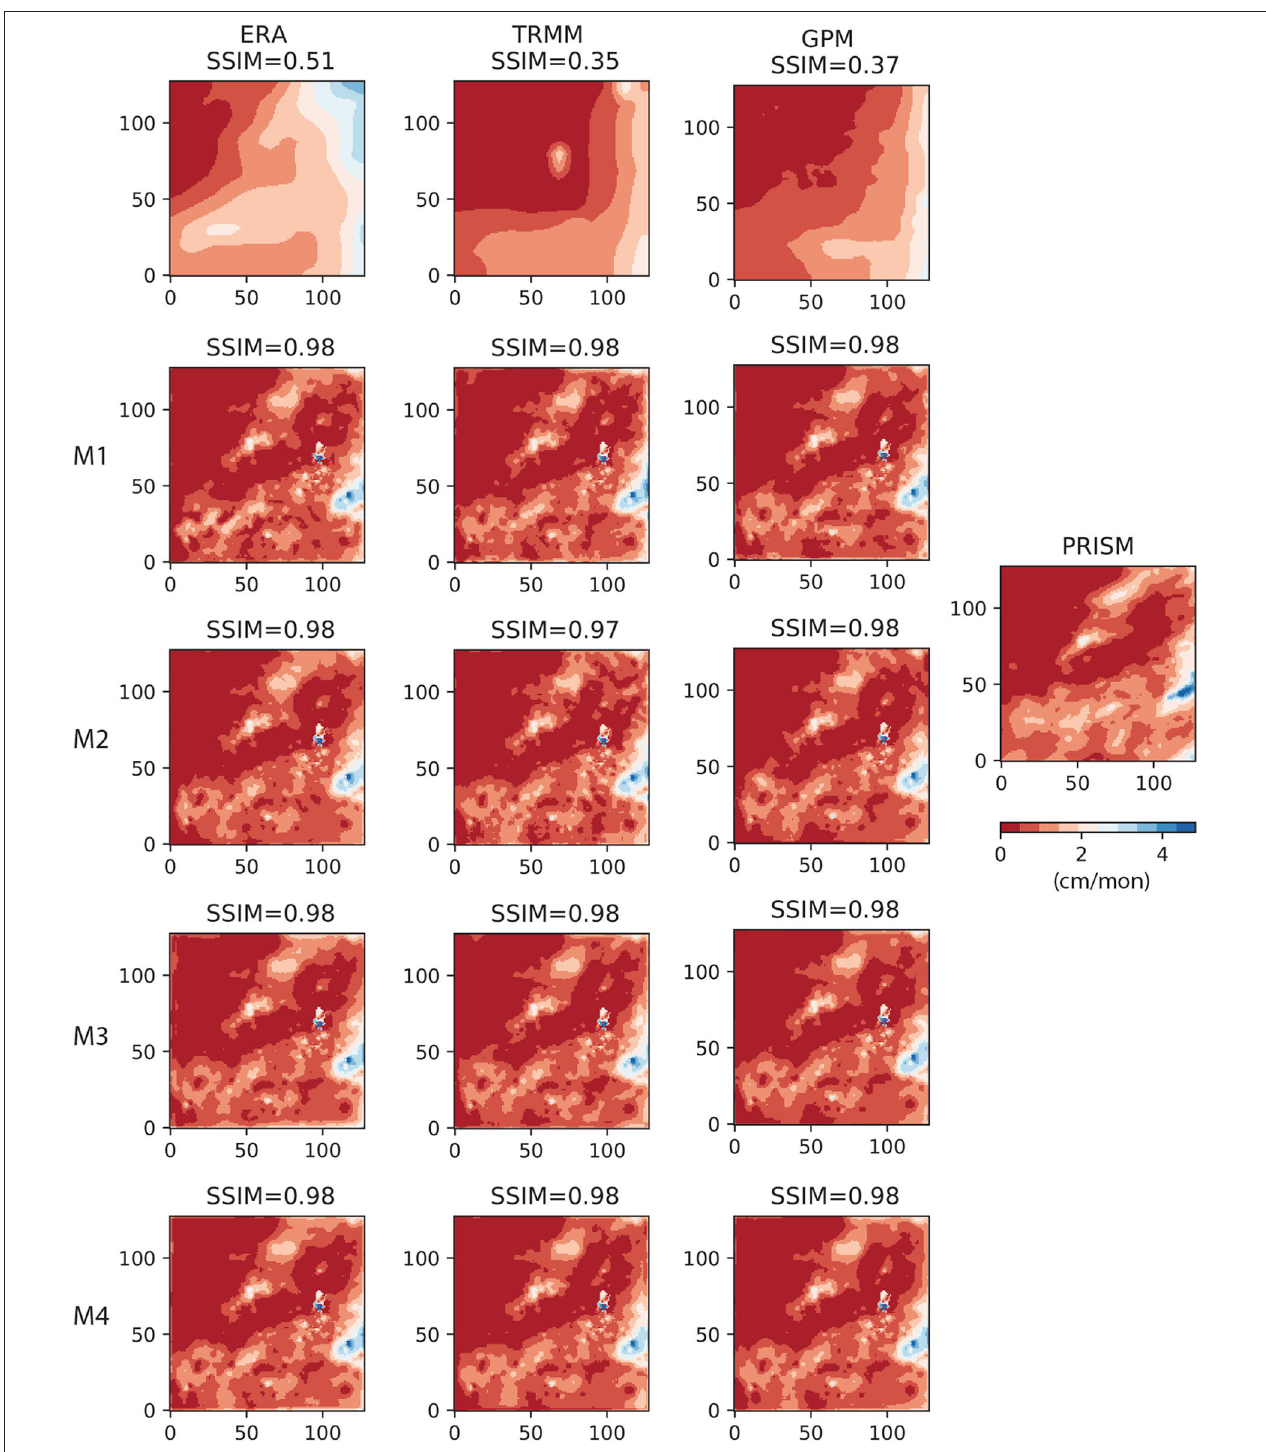
FIGURE 12 | Results of gauge correction on 2018/01 data. Left column (from top to bottom) ERA5 and the corresponding M 1 − M 4 AU-Net models; 2nd column: TRMM and the corresponding AU-Net models; 3rd column: GPM and the corresponding AU-Net models; rightmost column: reference PRISM data for the same